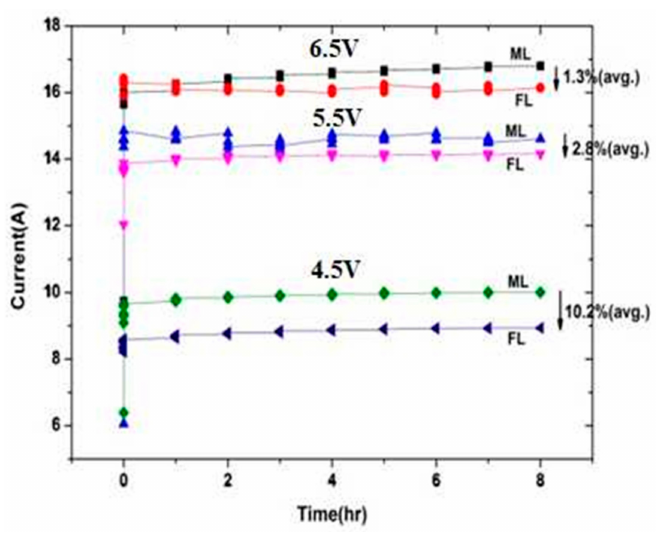
Figure 8. Current di ff erences under di ff erent applied voltages.